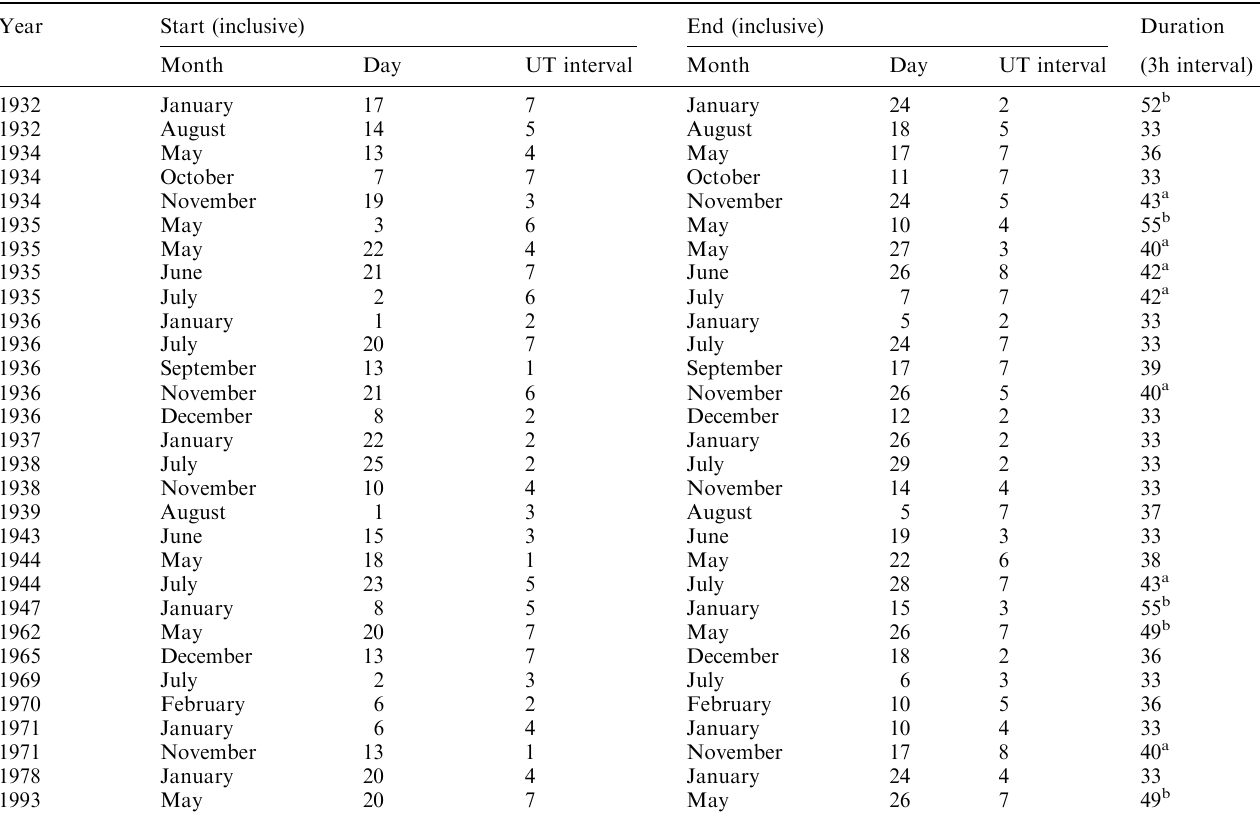
Table 3. Duration of at least 32 consecutive intervals of Kp = 0–1 in the period 1932–1995